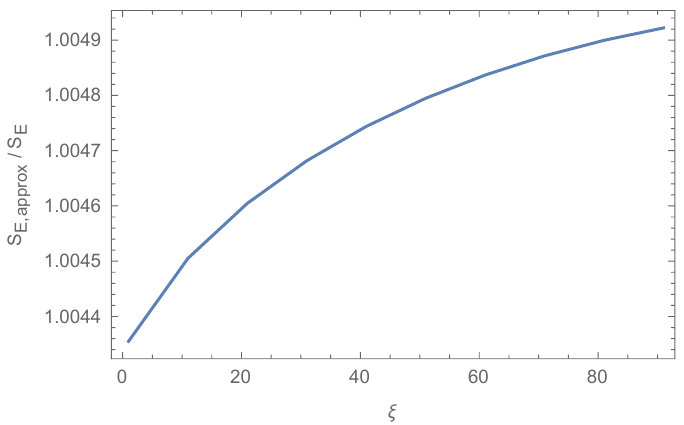
Figure 6. The actions computed using S E = 1 intersection is the point where the scaling relations are satisfied while the black dot represents the minimum of S . K